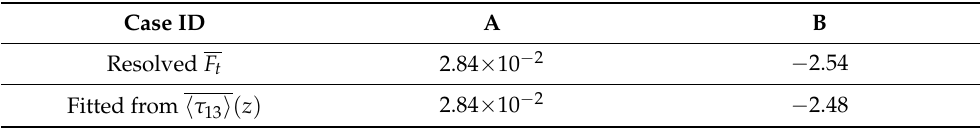
Table 4. The total drag ( F t ) as a function of the WA ref is approximated as F t / u ∗ 2 = A · WA ref + B , with coefficients given